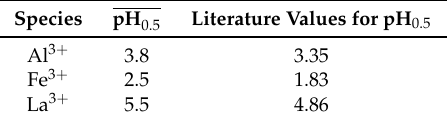
Table 4. Determined and literature [36] pH 0.5 values for the extraction of aluminum, iron and lanthanum.